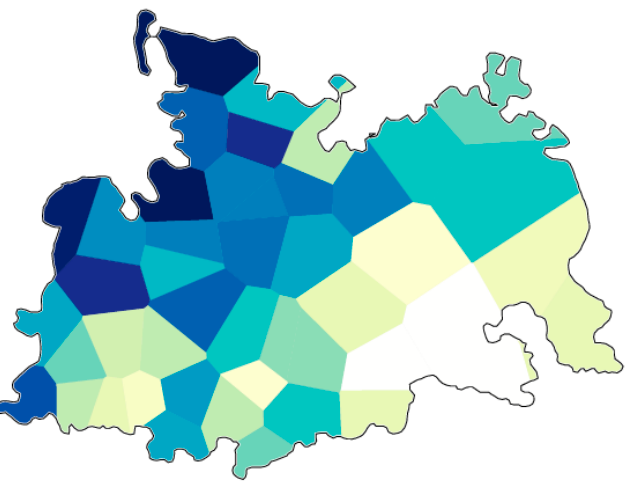
Figure 4. Proportion of respondents categorizing Low German as a language per region (using Gabmap; NGS2016).